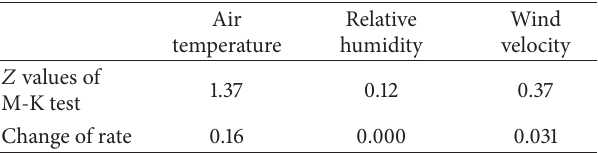
Table 5: 𝑍 values of M-K trend tests for annual mean of 1-hour (13:10–14:10) net radiation, air temperature, relative humidity, and wind velocity in Dongping Lake during